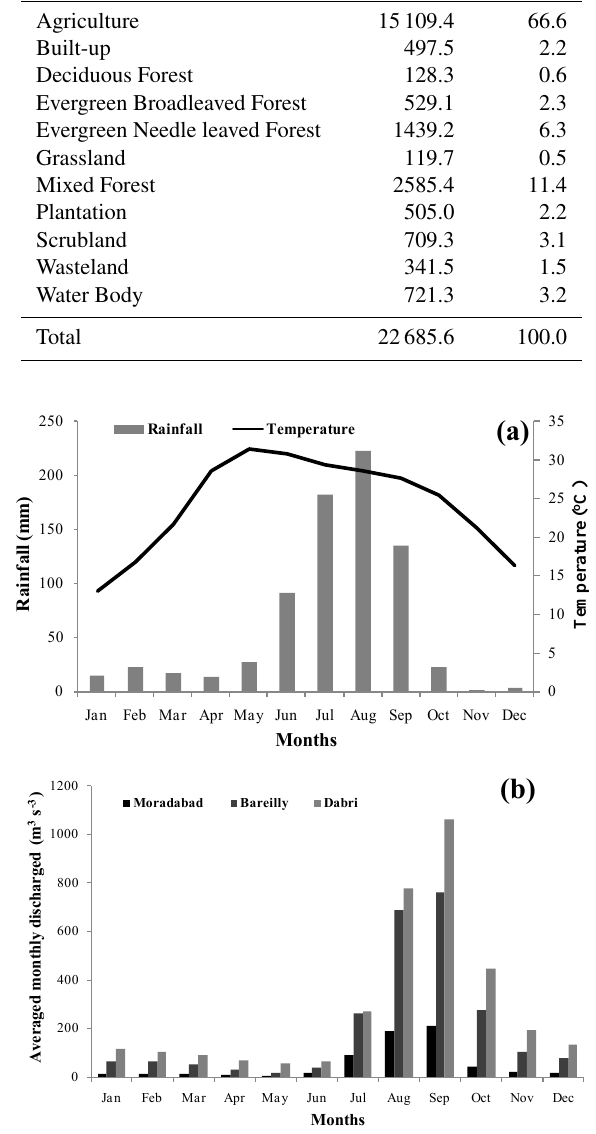
Figure 2. (a) Averaged monthly rainfall (mm) and temperature ( ◦ C) (b) Averaged monthly water discharge (m 3 s − 1 ) at three gauging sites of the study